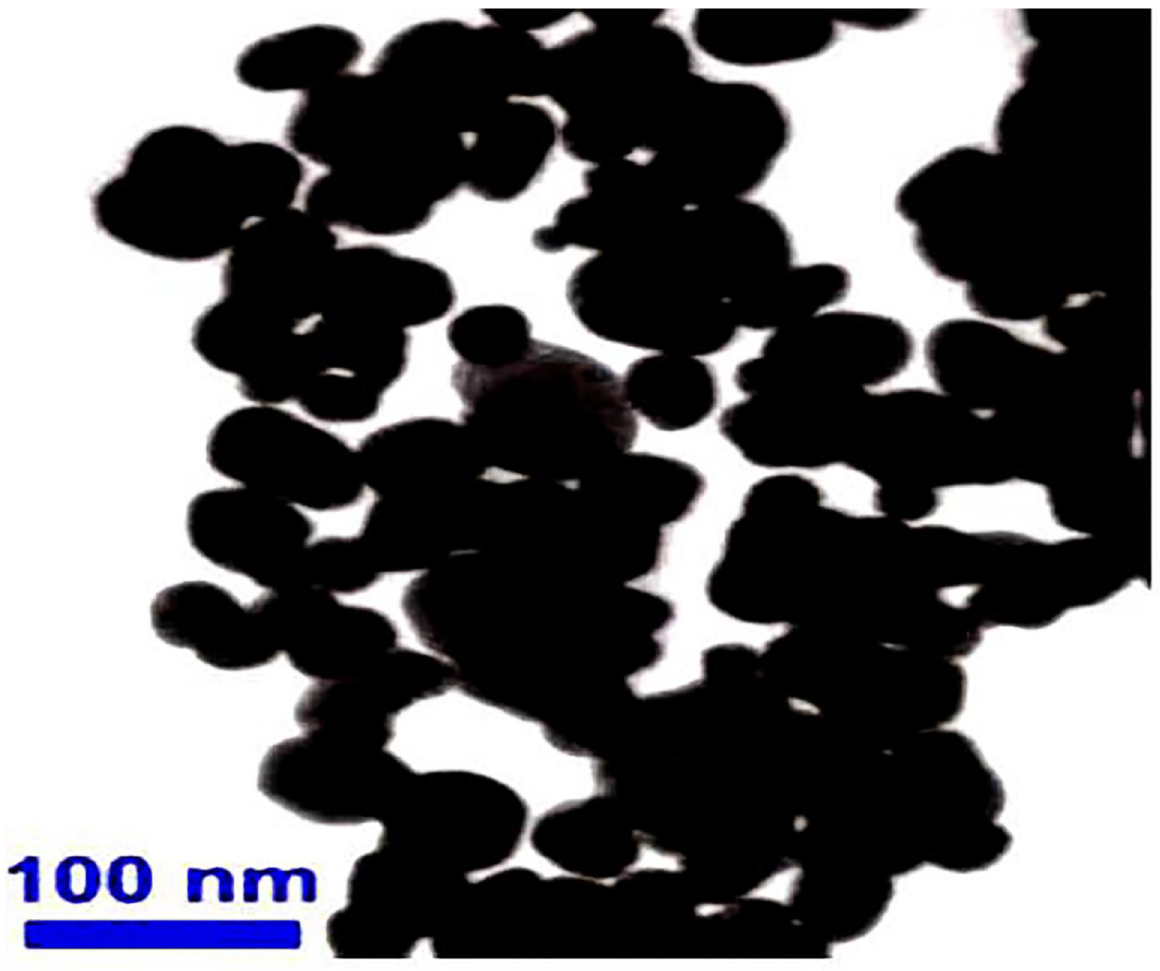
Fig 1. The morphology of silver nano powder illustrated by transmission electron microscope (TEM) ( Silver nano powder : Type nano powder = diameter 20nm; Format powder = content 99.9%; Specific surface area = 10–20 m2/g; Density = 0.25–0.6 g/cm3; Storage = Stored at